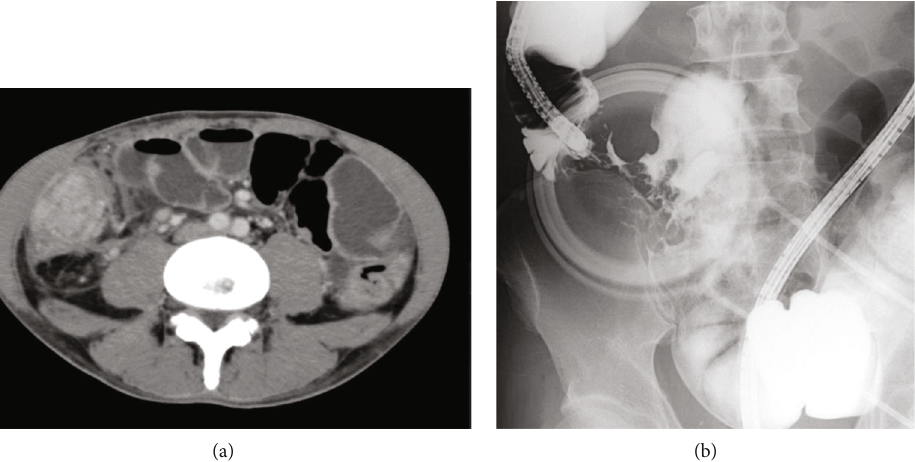
Figure 1: Preoperative radiographic fi ndings. (a) Contrast-enhanced computed tomography: wall thickening with contrast e ff ect is seen in the ileocecal region. (b) Endoscopic retrograde ileography: severe stenosis and deformation of the ileocecal